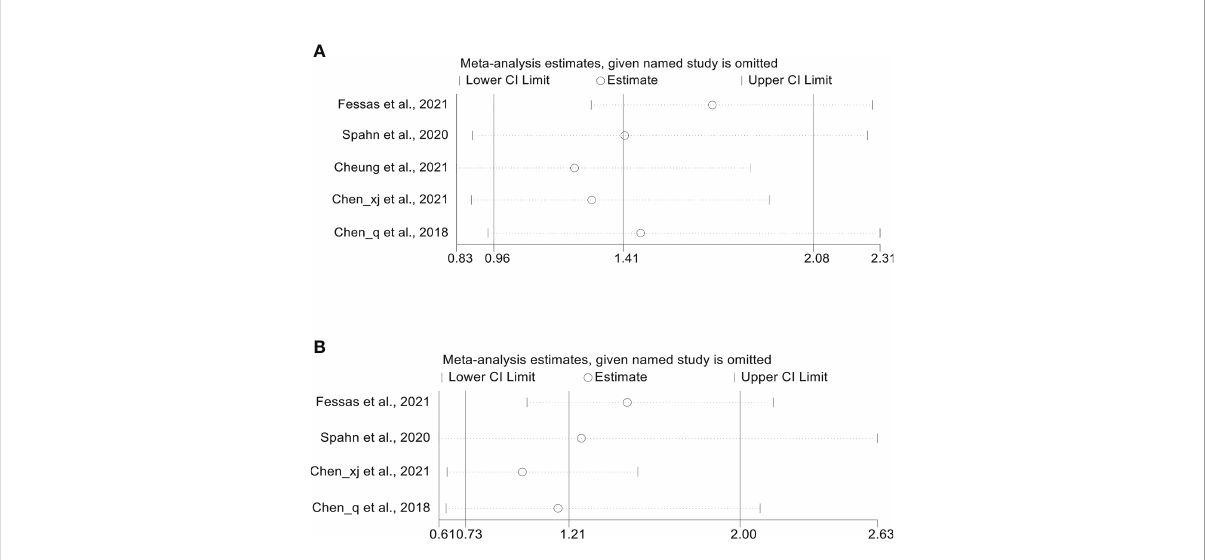
FIGURE 3 (A) Sensitivity analysis of the overall OS. (B) Sensitivity analysis of the overall PFS. OS, overall survival; PFS, progression-free survival; CI, con fi dence